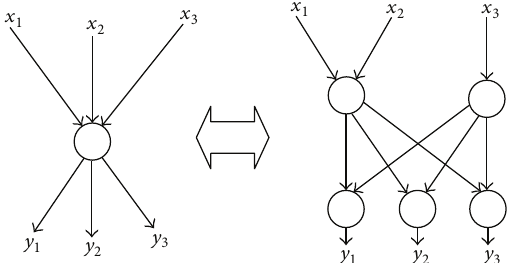
Figure 12: Transform a network into a new network with max (𝑛 In (𝑖)) = 2